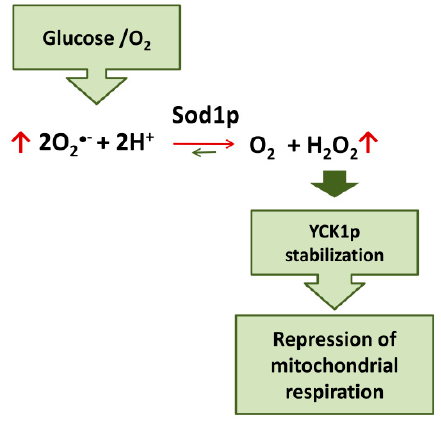
Figure 3. Sod1p mediates the repression of mitochondrial respiration by glucose / O 2 in yeast.